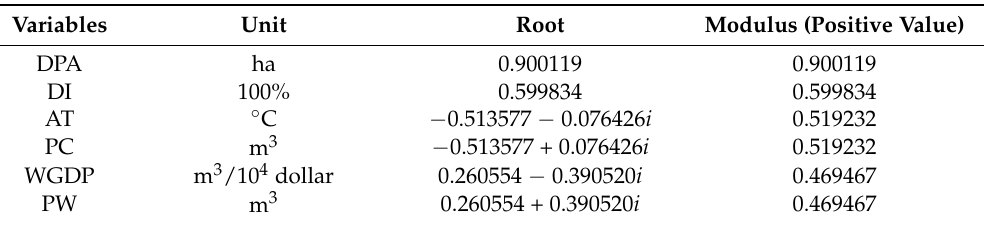
Table 5. VAR stability condition check.